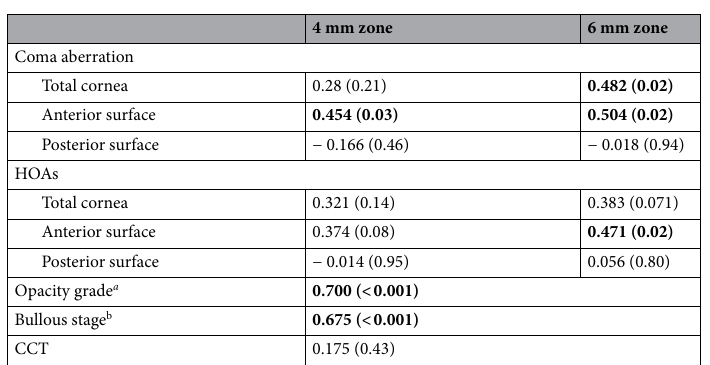
Table 3. Correlation between visual acuity, coma aberration, HOAs, opacity grade, bullous stage, and CCT. Data are expressed as Spearman’s correlation coefficient r s ( P ). Bold numbers indicate P < 0.05. CCT, central corneal thickness; DM, Descemet’s membrane; HOAs, higher order aberrations; IQR, interquartile range; SA, spherical aberration. a corneal opacity grade; 0, clear or trace haze; grade 1, mild opacity; grade 2, moderately dense opacity partially obscuring the details of the iris; and grade 3, severely dense opacity obscuring the details of the intraocular structures. b The severity of bullous keratopathy was defined as follows: stage 1, slight stromal edema or increased corneal thickness due to reduction in corneal endothelial cells; stage 2, stromal edema with DM folds; stage 3, stromal edema and DM folds with apparent epithelial bullae; stage 4, stromal scarring and corneal